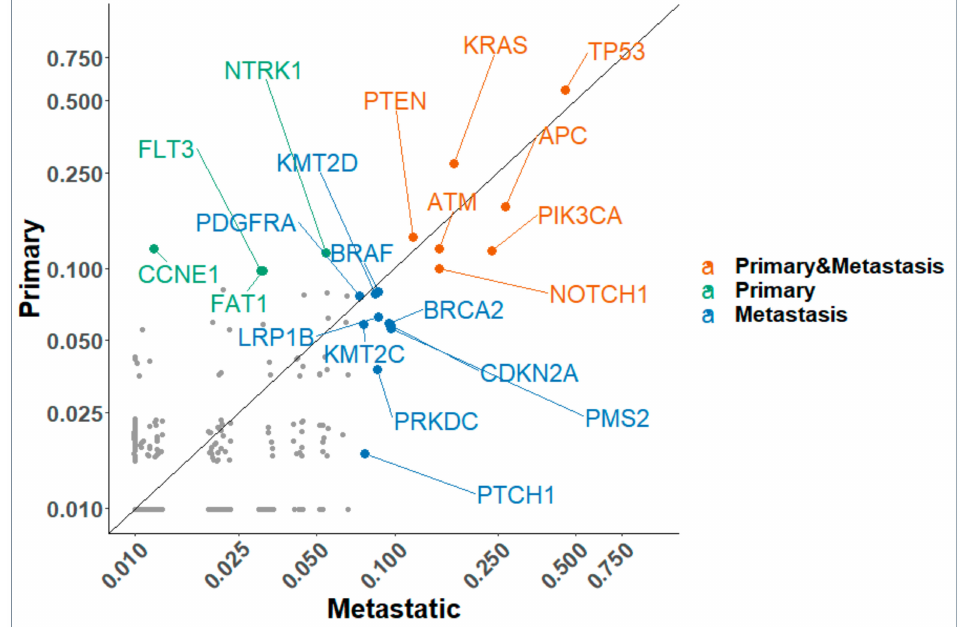
Figure 2. Scatter plot of frequencies of gene mutations in primary and metastatic samples. Genes that are enriched in primary, metastatic or both samples with p value < 0.05 are